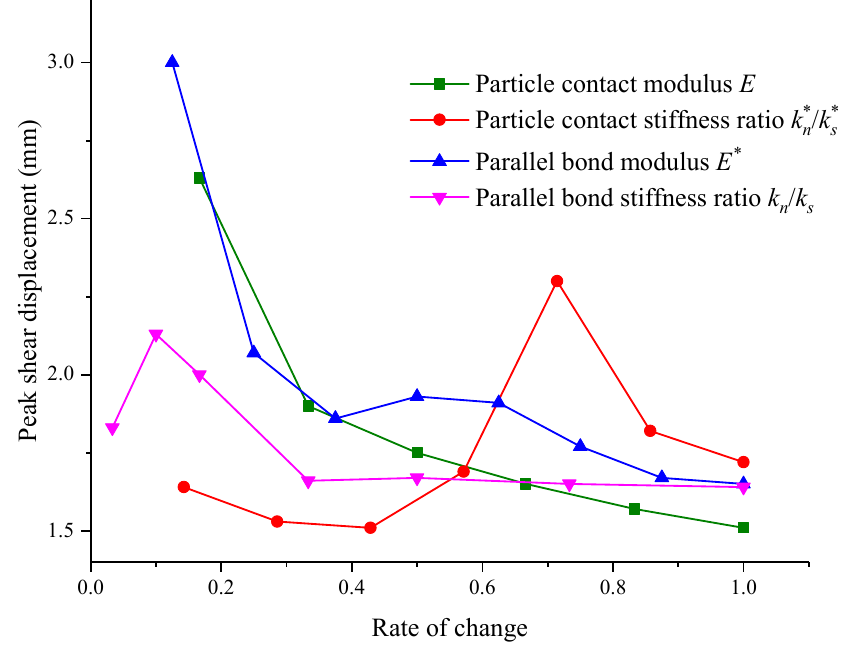
Figure 12. Relationships between micro-parameters and peak shear displacement. As shown in Figure 11, the influences on shear strength of the contact modulus of particles, contact stiffness ratio and parallel bond modulus are small, but differences between these three factors exist. In general, the contact modulus and parallel bonding modulus can increase the shear strength. As the contact modulus increase, the corresponding shear resistance strength increases as well. When the change rate of contact modulus is 0.8, the shear resistance would be reduced a little. However, in general, the increment of contact modulus has a certain contribution to the incrementation of shear resistance strength. The increments in parallel bond modulus also contribute to the shear resistance strength,